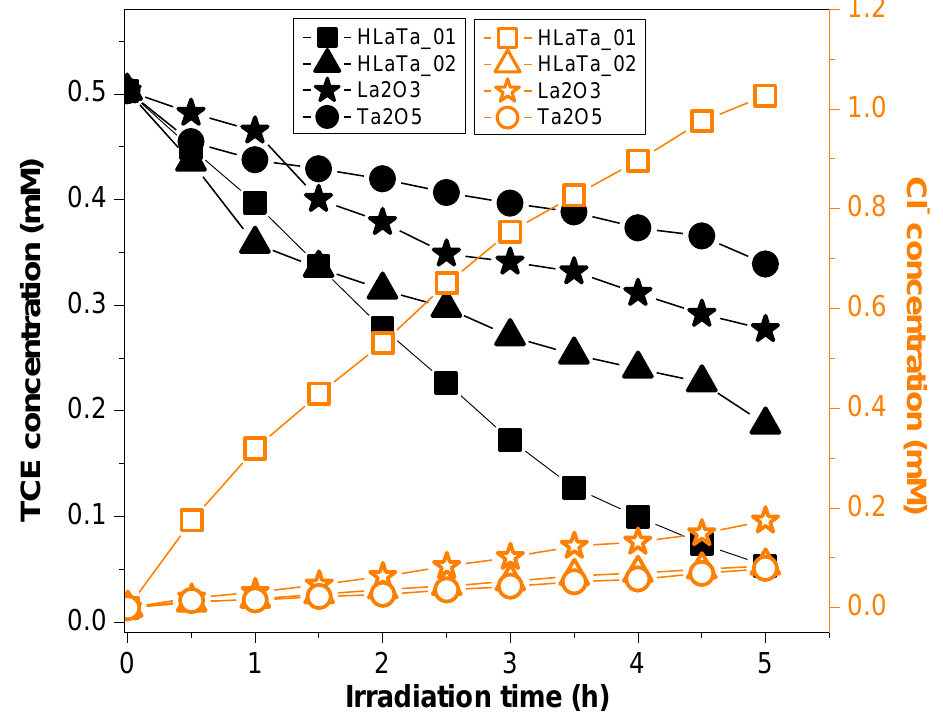
Figure 10. Time-evolution of trichloroethylene (TCE) and Cl − concentrations over HLaTa_01(02) protonated photocatalysts and the commercial oxides. Closed symbols stand for TCE concentration, whereas the open symbols represent Cl − concentration. Experimental conditions: initial concentration of TCE = 5 mg·L −1 ; T = 18 °C; simulated solar irradiation, m catalyst = 0.05 g; V water = 110 mL.